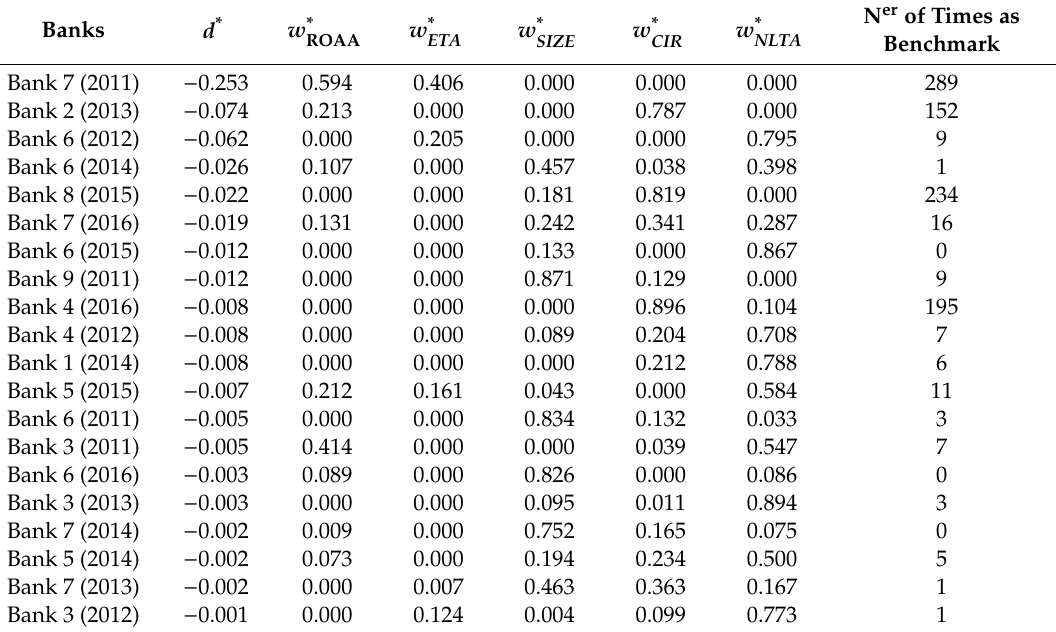
Table 7. Results of value-based data envelopment analysis (DEA) (e ffi ciency score and optimal weights) and number of times as benchmarks, for e ffi cient